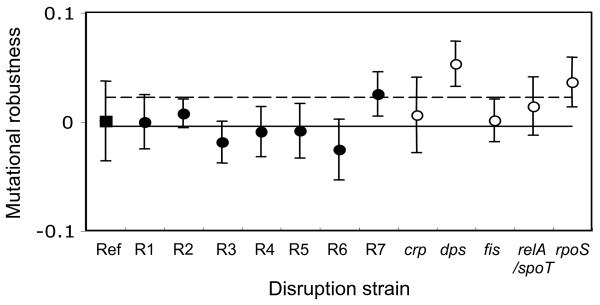
Robustness of random and targeted hub deletion mutants to mutational stress. Average of median values for each of the 30 secondary mutations made in each strain is plotted. Error bars indicate standard errors. Reference strain (ref), solid square; random disruption strains, solid circles; targeted hub disruption strains, hollow circles. Solid line indicates mean of random disruption strains; dotted line indicates mean of targeted hub disruption strains.